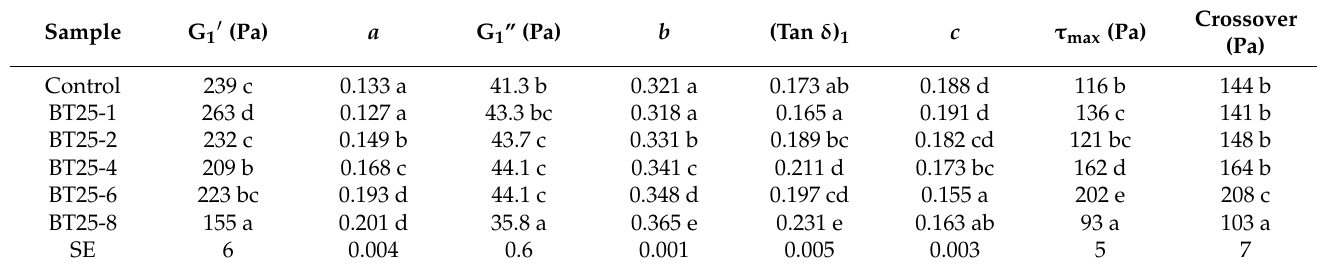
Figure 3. Pasting profiles of control and MW-treated brown tef flour at 12 ( a ), 15 ( b ), 20 ( c ), and 25% moisture content ( d ). tef flour native (control). Black, blue, green, yellow, brown, and red lines cor- Table 3. Rheological properties of MW-treated samples at 25% moisture content. respond to untreated, 1 min, 2 min, 4 min, 6 min, and 8 min treated samples, respectively, and grey discontinuous lines correspond to the temperature profile.